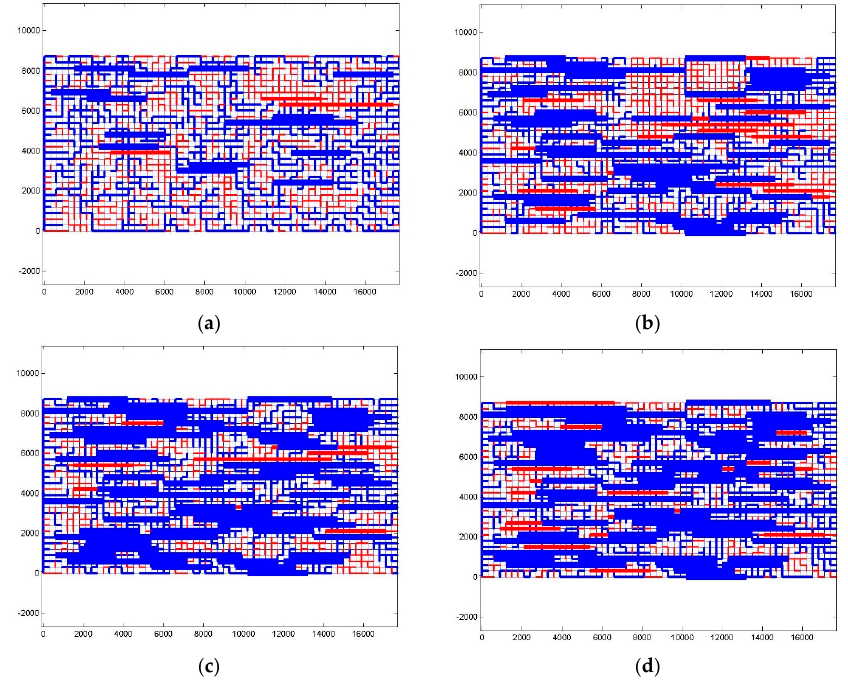
Figure 10. The distribution of oil-water state at the end of displacement with different fracture numbers in Type II (The red throats and fractures are filled with oil and the blue throats and fractures are filled with water). ( a ) (cid:1840) (cid:3033) = 20; ( b ) (cid:1840) (cid:3033) = 80; ( c ) (cid:1840) (cid:3033) = 120; ( d ) (cid:1840) (cid:3033) = 160.